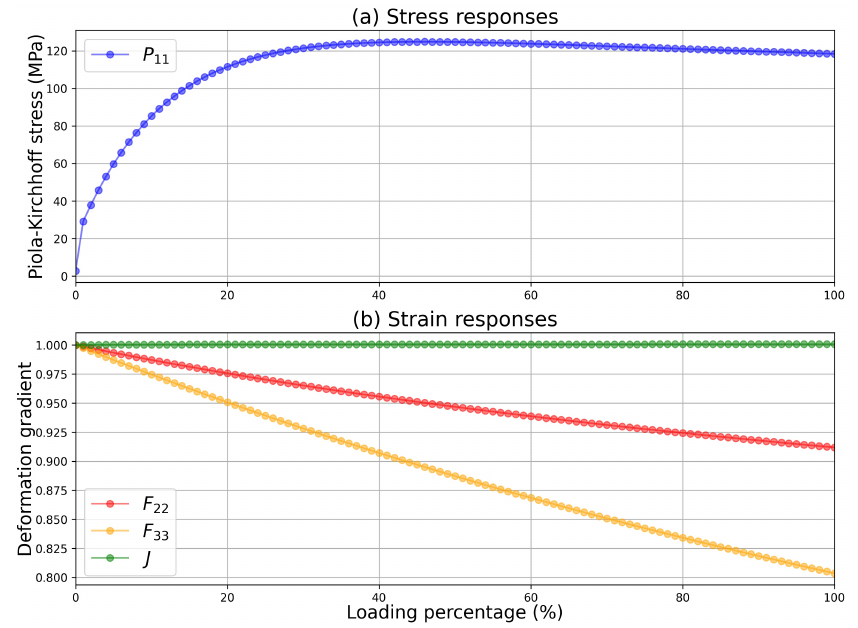
Figure 1. ( a ) The component P 11 of the Piola–Kirchhoff stress, ( b ) components F 22 and F 33 of the deformation gradient, and the determinant J as functions of the loading percentage under uni-axial traction. With the Euler angles [ 128.0 ◦ ,40.0 ◦ ,37.0 ◦ ] , components F 22 and F 33 have different